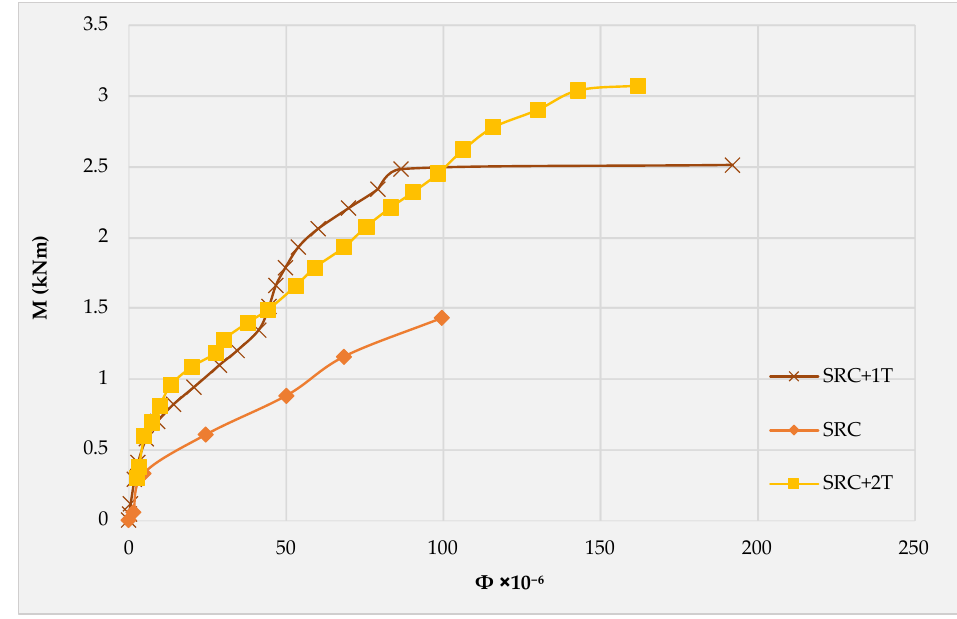
Figure 10. Bending moment versus curvature curve plot for the three tested slab specimens.